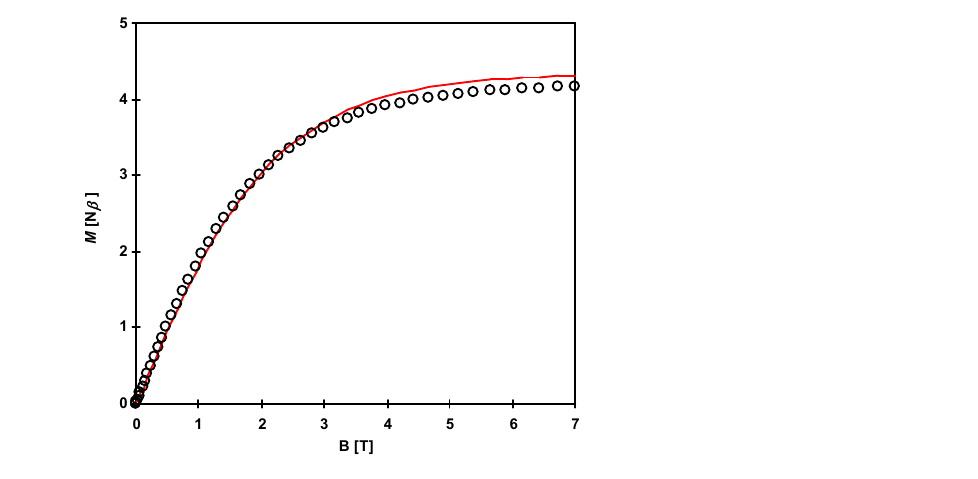
Figure 11. Field dependence of the magnetization for 1 at 1.8 K. The solid red line is the best fit for the model described in the text.